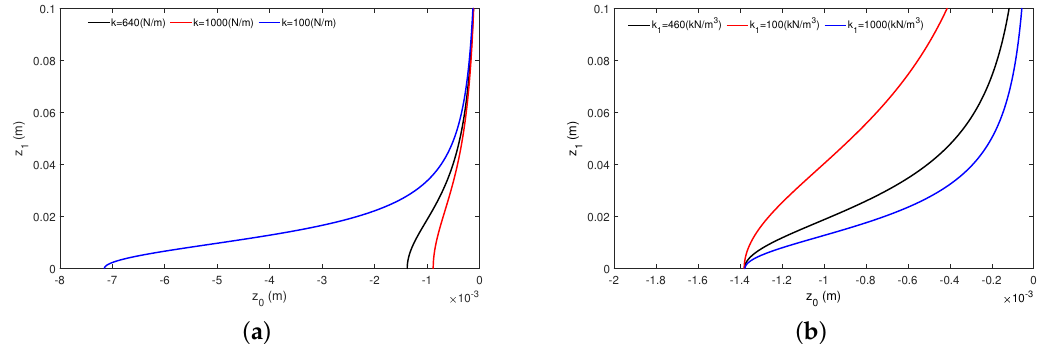
Figure 6. An influence of the linear ( a ) and nonlinear ( b ) stiffness components on the magnet vibration centre. The diagrams have been obtained for parameters k 1 = 460 kN/m 3 and k 1 for k = 640 N/m from the Equation (28).